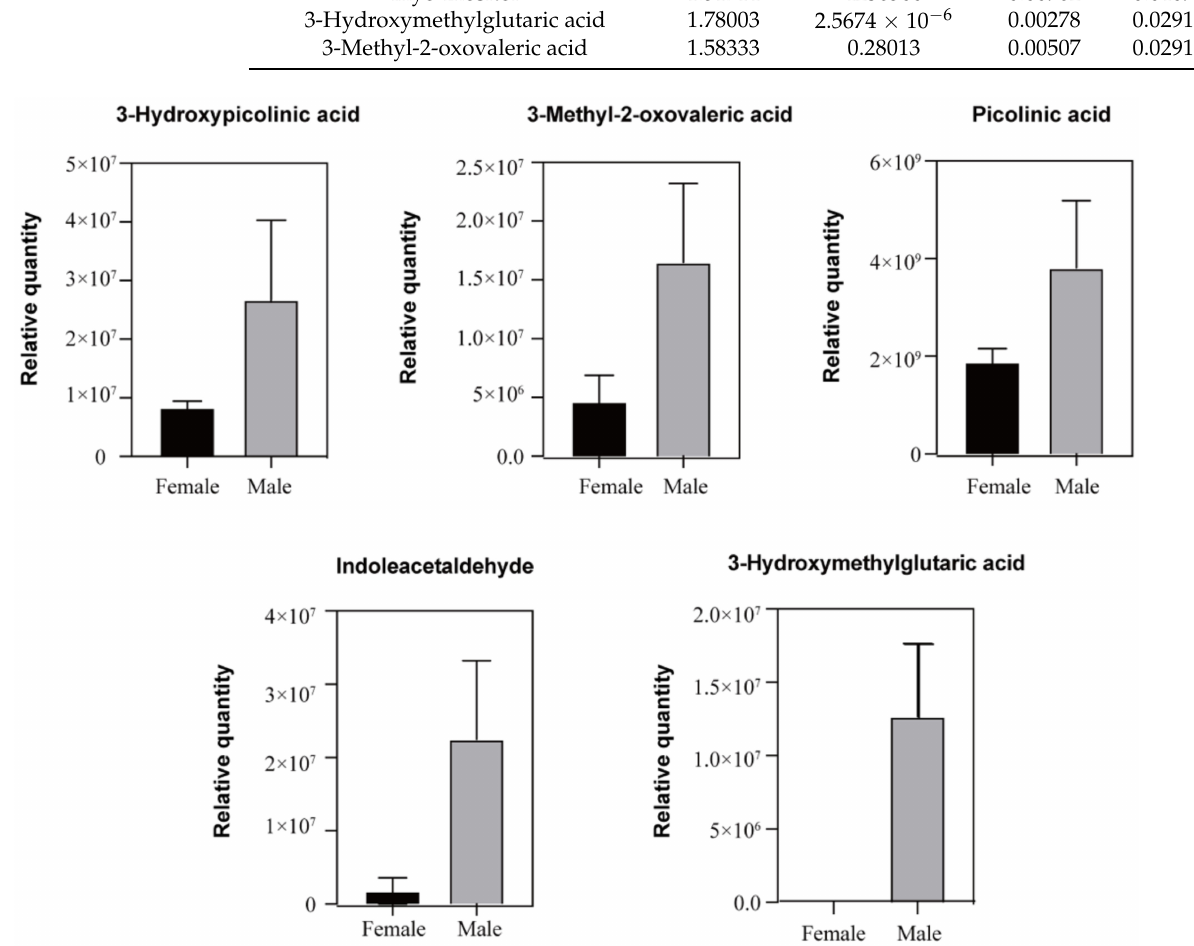
Figure 6. The histogram shows the differences between the sexes regarding the relative expression of the volatile secretions from the uropygial glands. All these substances are significantly higher in males than in